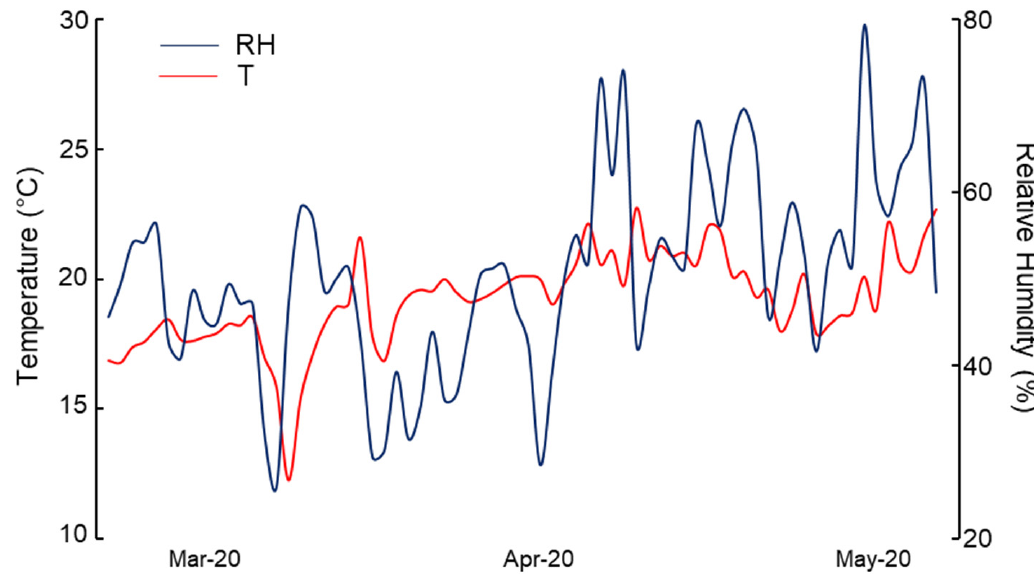
Figure 2. Daily average of temperature (red) and relative humidity (blue) of air recorded in the greenhouse during the wild rocket cultivation.